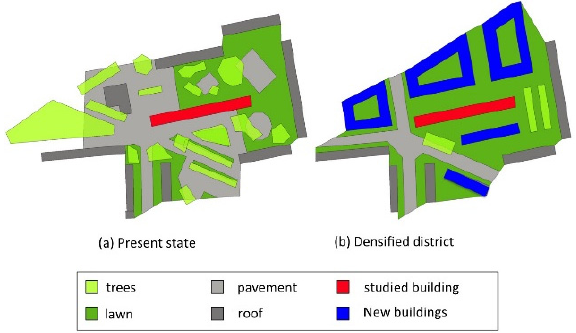
Figure 1. Block plans for the district, in both ( a ) its present state and ( b ) following densification.